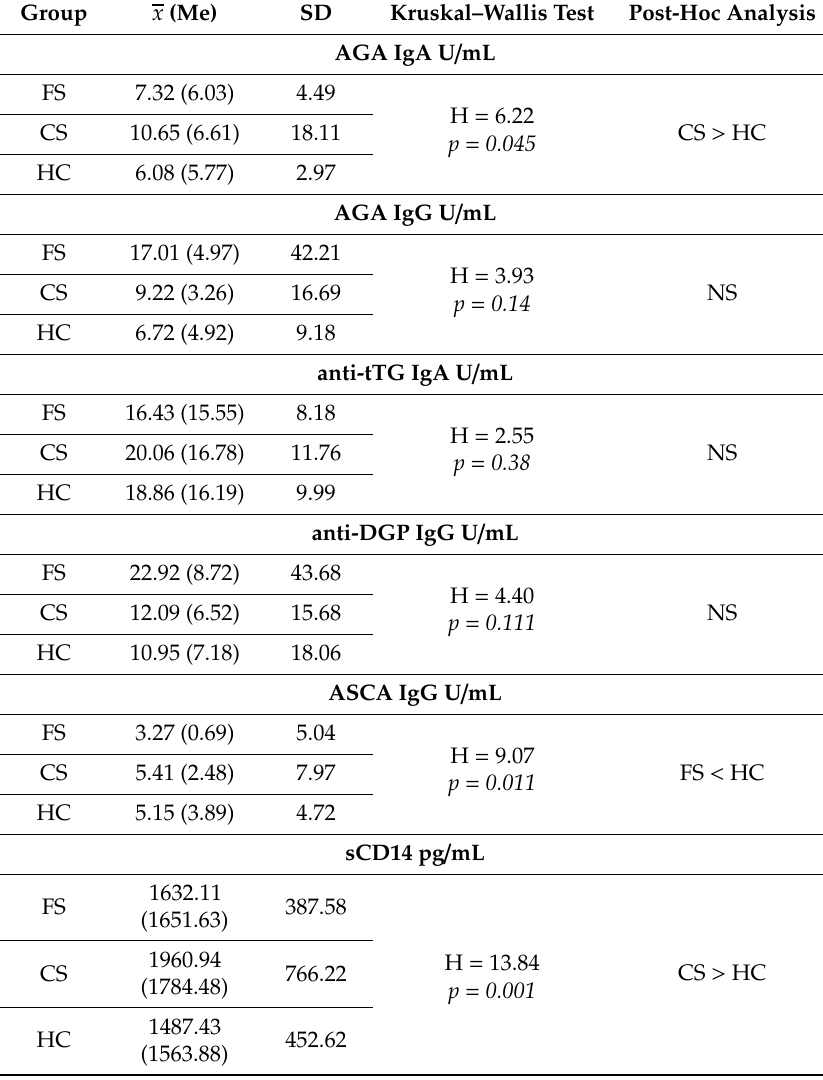
Table 2. Di ff erences in serum concentrations of gluten sensitivity, gut permeability, and inflammatory markers among the examined